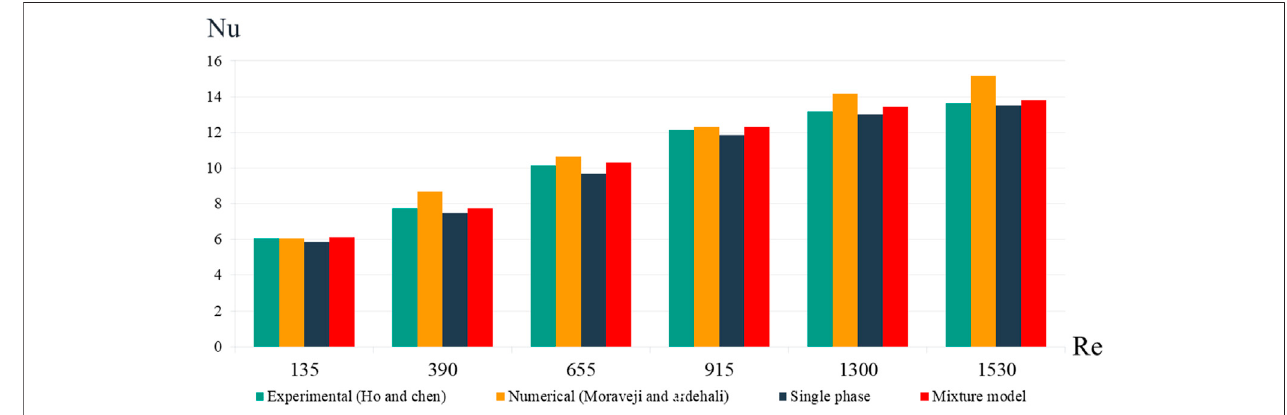
FIGURE3| ComparisonoftheaverageNusseltnumberbetweenthepresentstudy,anexperimentalwork(HoandChen,2013),andanumericalone(Moravejiand Ardehali, 2013).